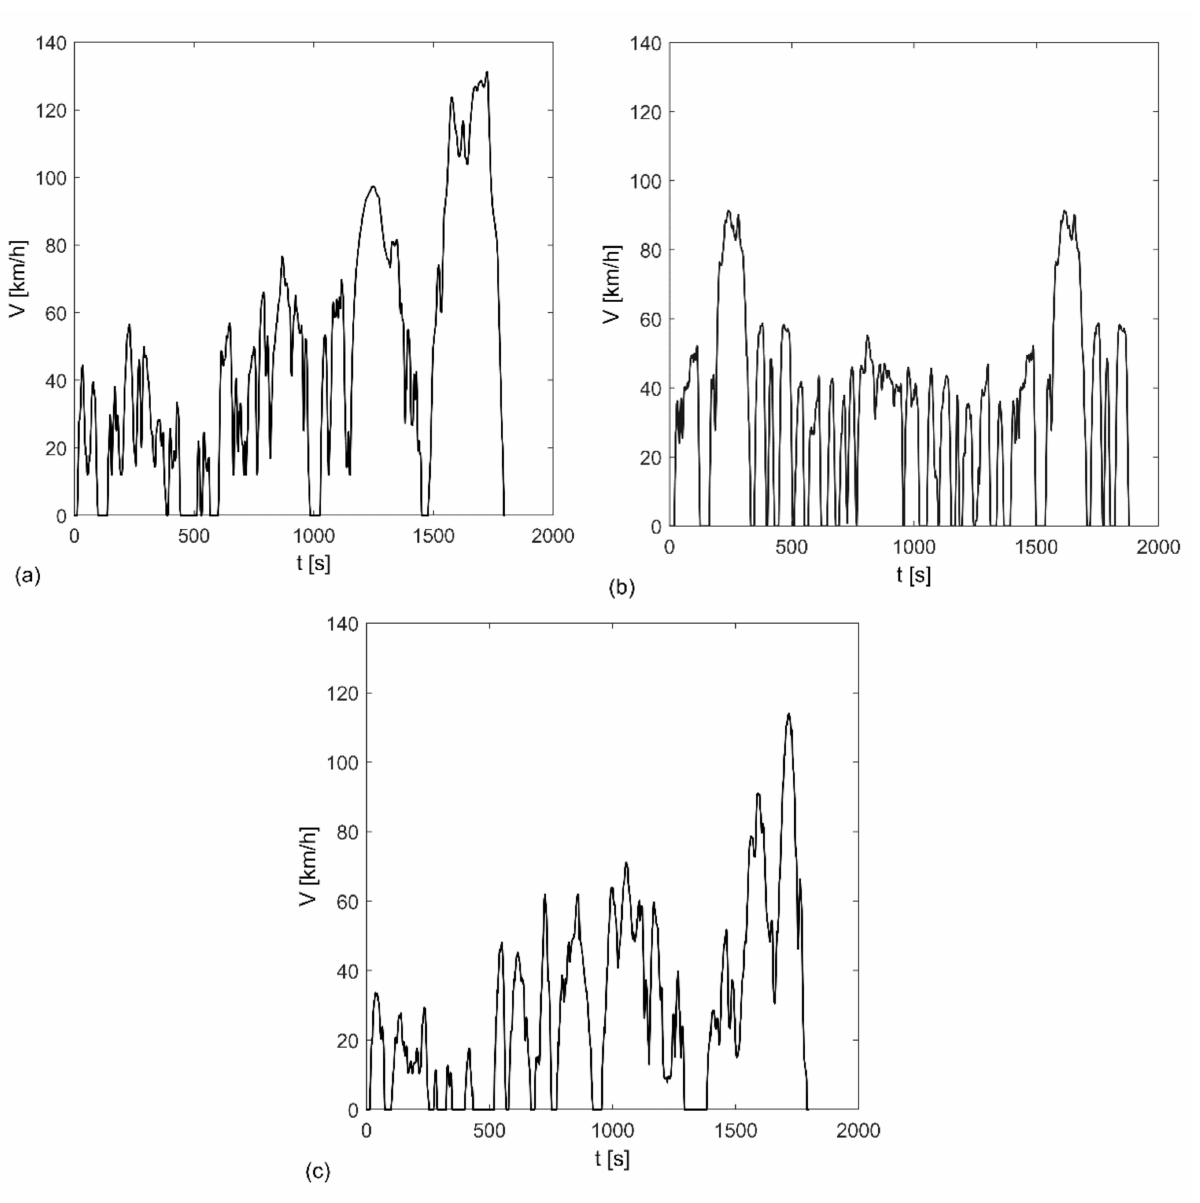
Figure 3. Speed versus time of ( a ) WLTC 3b, ( b ) FTP-75, ( c ) CLTC-P driving